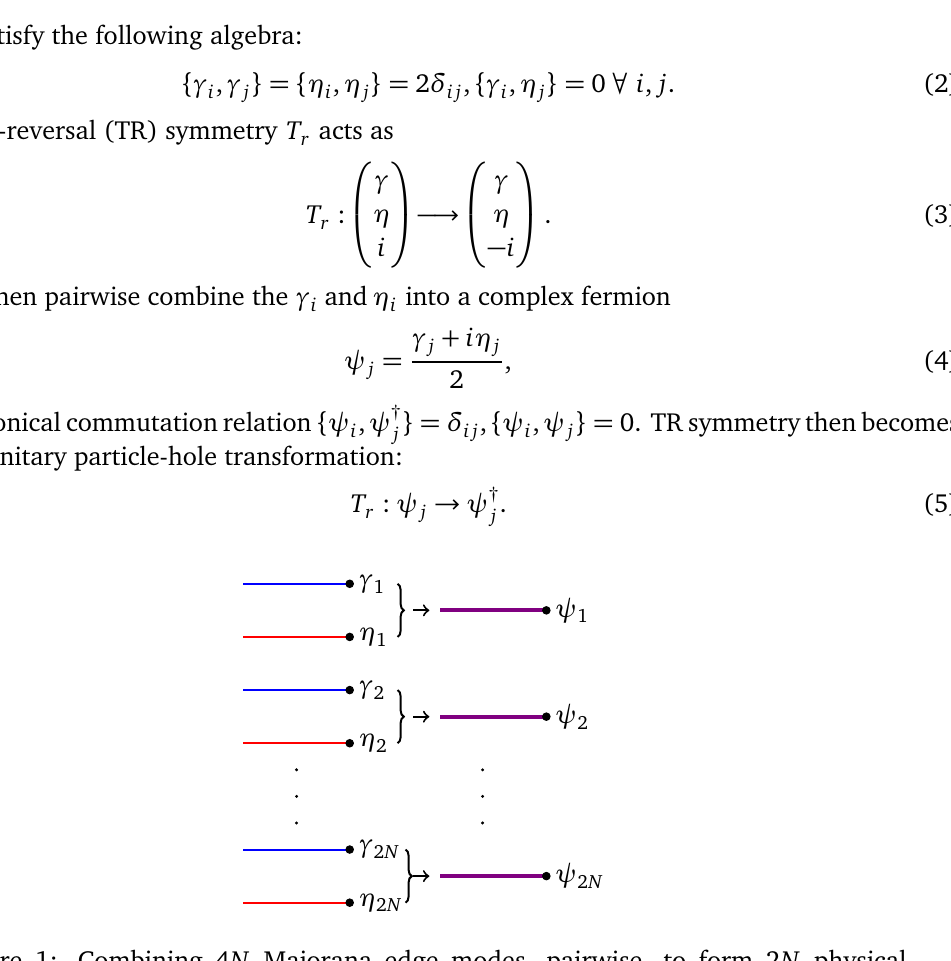
Figure 1: Combining 4 N Majorana edge modes, pairwise, to form 2 N physical